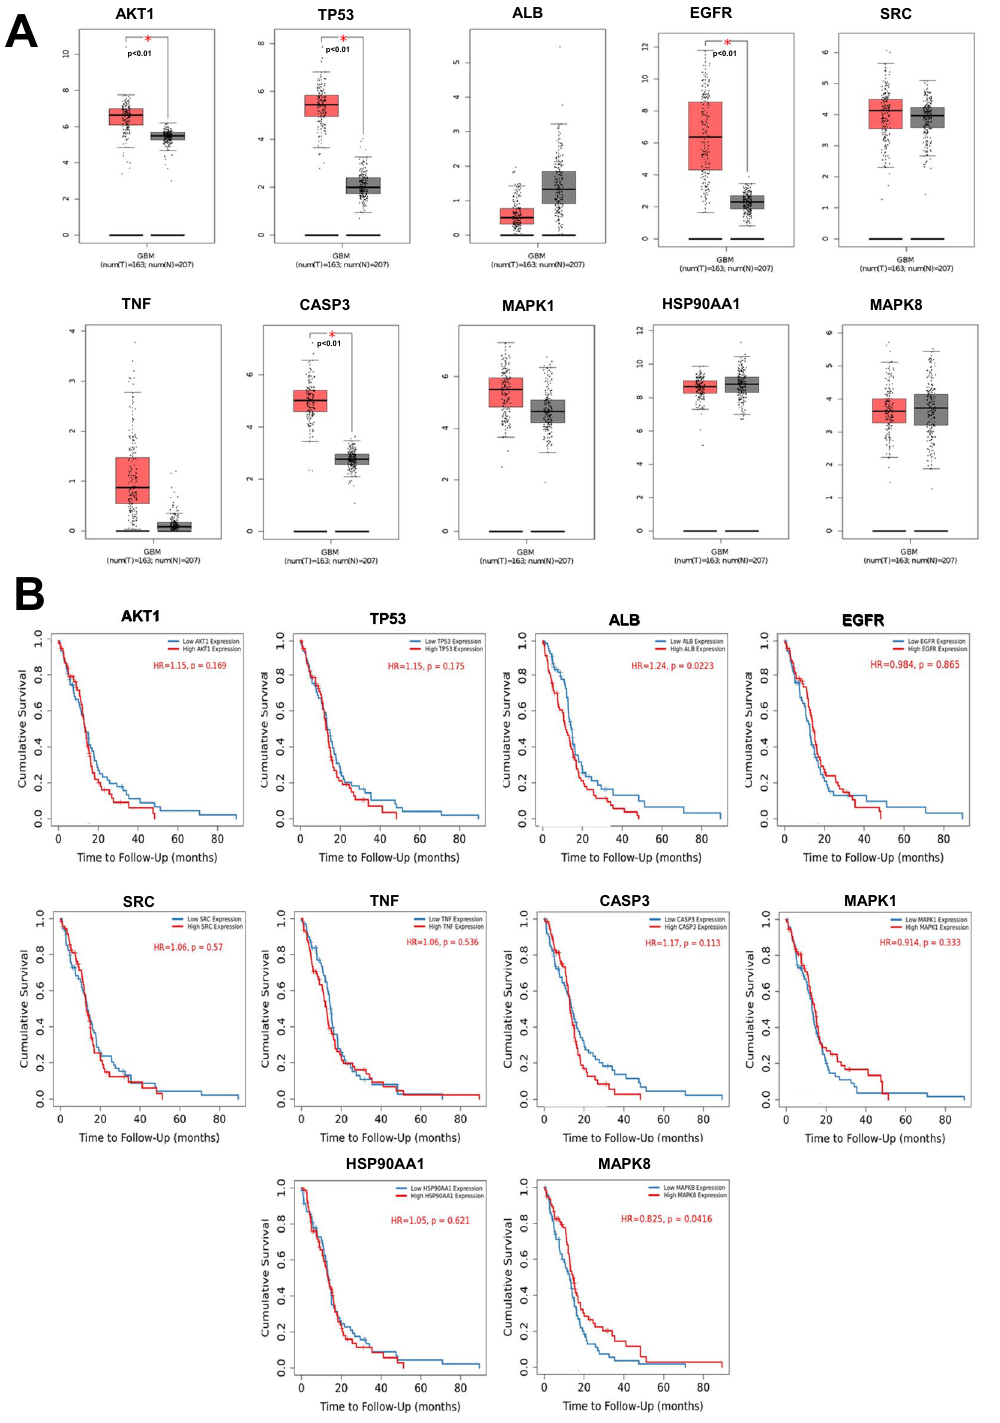
Figure 5. ( A ) Gene expression analysis of 10 PTCGs in patients with GBM and adjacent normal tissues from TCGA, as analyzed using GEPIA. ( B ) Relationships between the overall survival of patients with GBM and the expression of 10 PTCGs, as analyzed using TIMER